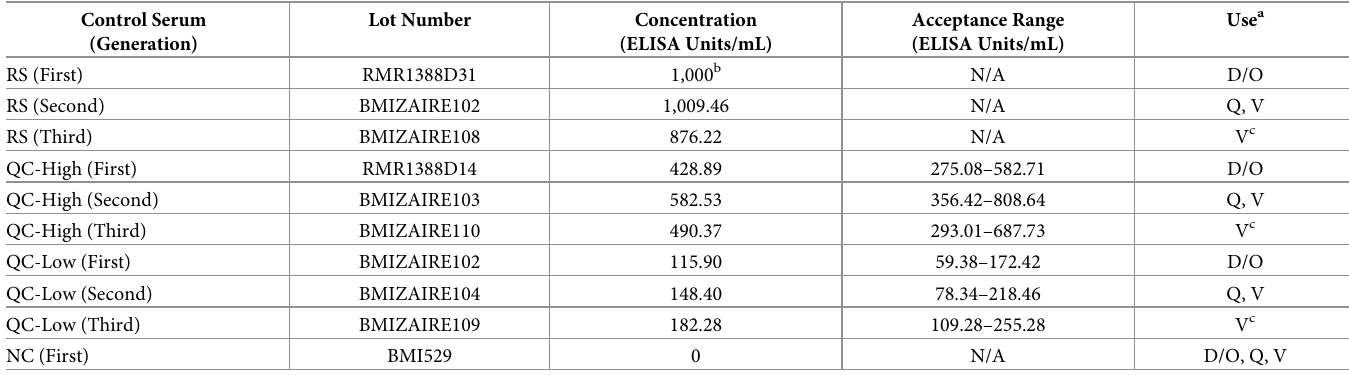
Table 1. Summary of control serum lot qualifications.